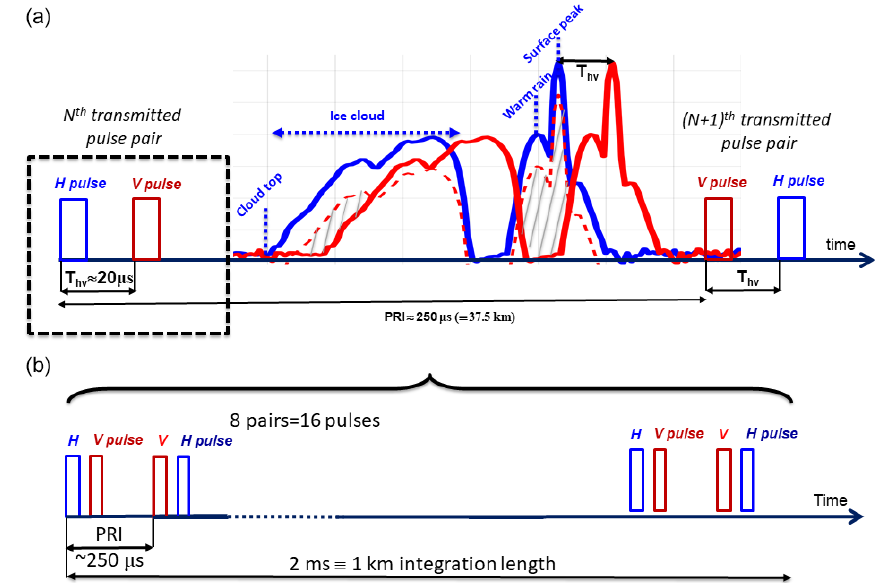
Figure 8. (b) The timing of the transmitted pulse sequence proposed for WIVERN with interlaced H - V pairs. A sequence of M = 8 pairs correspond to 2ms, equivalent to a 1km distance along the scanning track. Note that the order of the polarization state of each pulse pair is switched from pulse to pulse in order to cancel out differential phase shift effects between the two channels. (a) Example of the return echoes from a scene including an ice cloud, a cloud-free region, and warm rain above a strongly reflecting surface. The returns in the H channel are plotted in blue and those in the V channel (lagging by 20µs) in red. The dashed red line corresponds to the interference caused by the blue H pulse encountering a depolarizing target. A very high depolarization ratio of − 10dB has been used to exacerbate this effect that leads to returns in regions void of hydrometeors (later referred to as ghosts) in the red H channel. The hatched areas represent ranges where the ghosts exceed the co-polar signal. In this case, the one from the ground and the warm rain is much more serious (and appears shifted upward by circa 3km in correspondence to the cloud-free region) than the one caused by the large Z gradients at the top of the cloud. A similar reasoning applies to the H channel (not shown for clarity of